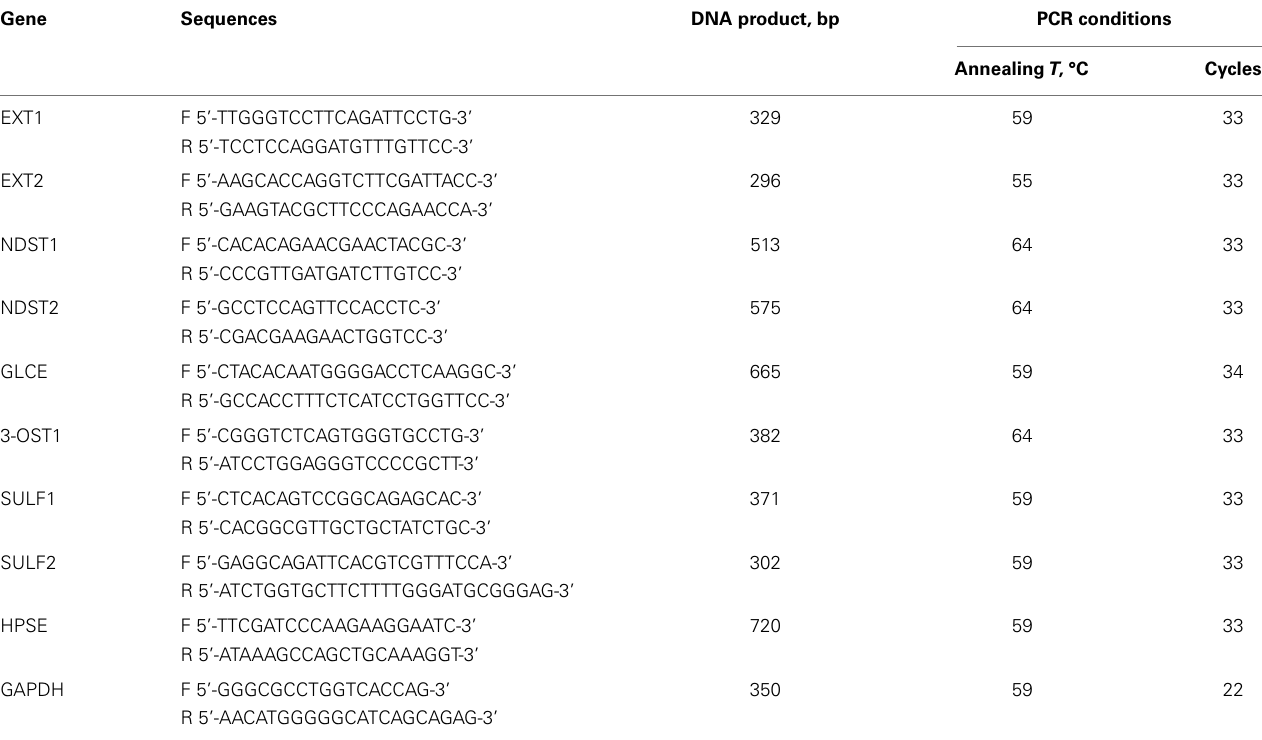
Table 1 | Primer sequences and PCR conditions